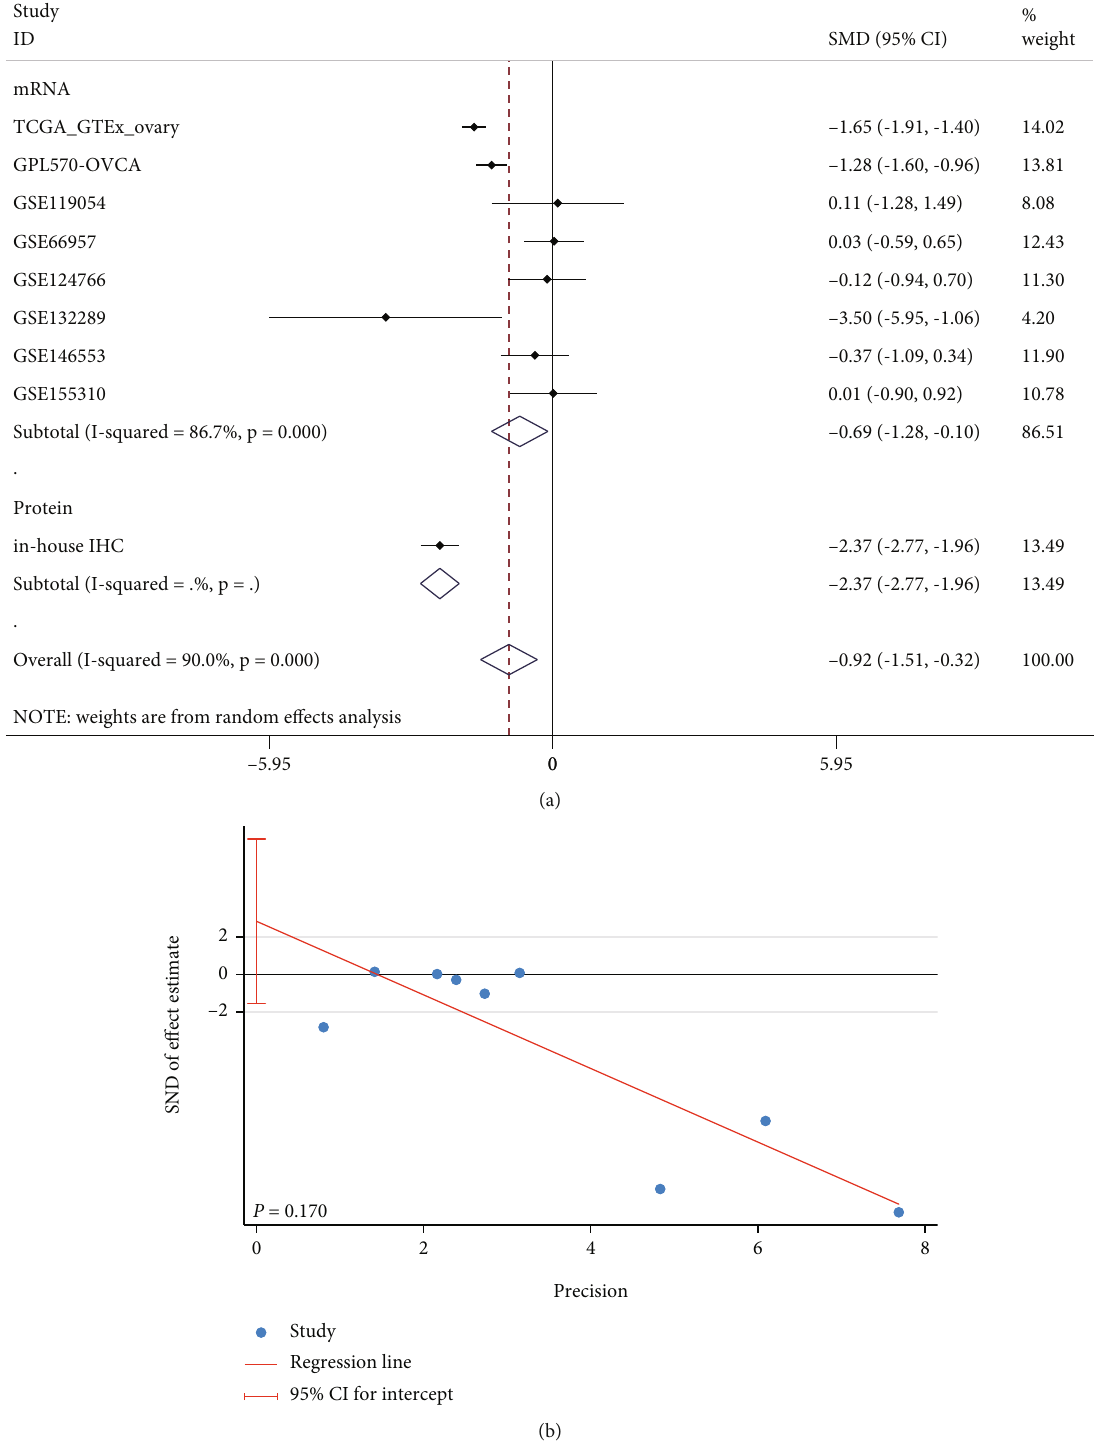
Figure 4: Combined standard mean di ff erence (SMD, (a)) of CCDC80 expression between OVCA and non-OVCA group and Egger ’ s test (b) for publication bias test (in mRNA group, TCGA_GTEx_ovary was a cohort of RNA-seq, and other cohorts began with “ GSE ” were gene chip